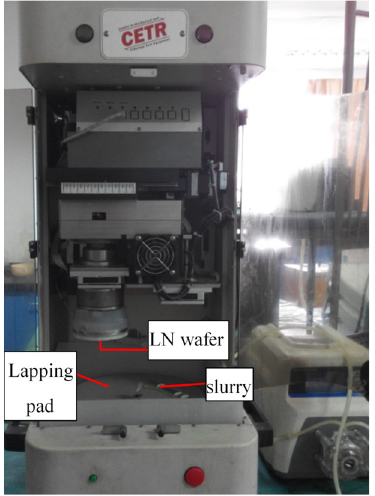
Figure 4. Fixed-abrasive lapping tests with CP-4 test system.